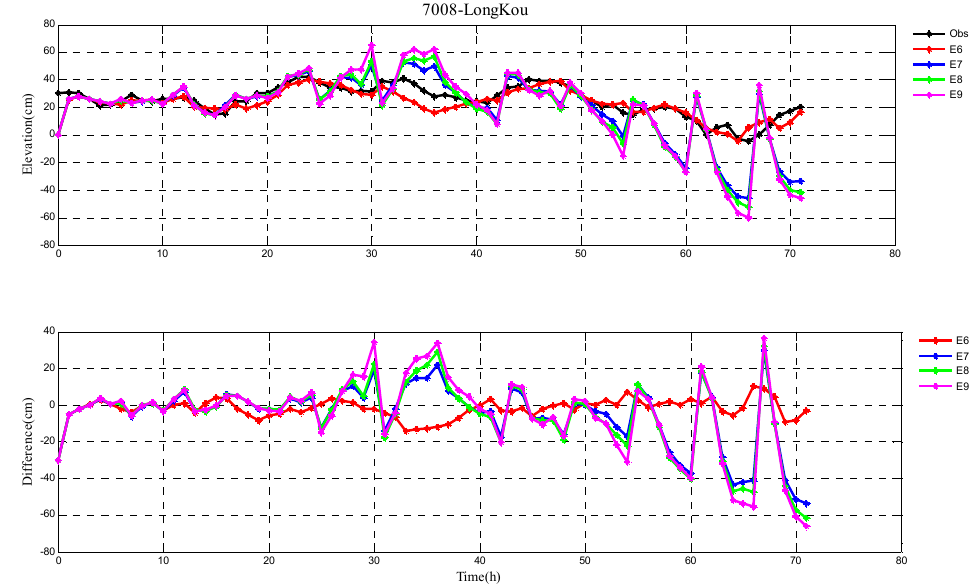
their differences ( bottom ) during Typhoon 7008 at YingKou station.